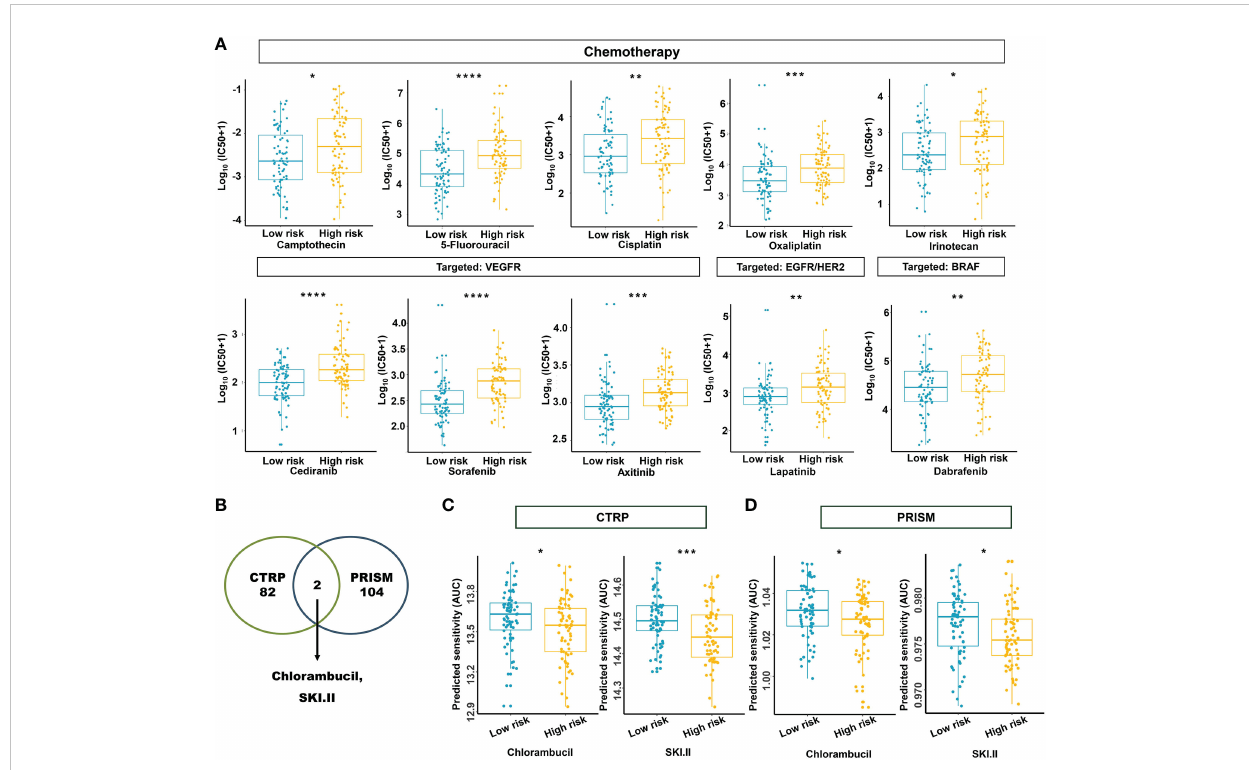
FIGURE 12 Estimation of drug sensitivity for the m 5 C methylation-based signature. (A) The evaluation of drug sensitivity including chemotherapeutics and small molecular drugs targeting VEGFR, EGFR/HER2, and BRAF. (B) Intersection of the identi fi ed drugs targeting high-risk patients between CTRP and PRISM databases. (C, D) The differential drug response analysis of CTRP- and PRISM-derived compounds targeting the high-risk group. IC50: half- maximal inhibitory concentration. **** P < 0.0001; *** P < 0.001; ** P < 0.01; * P <